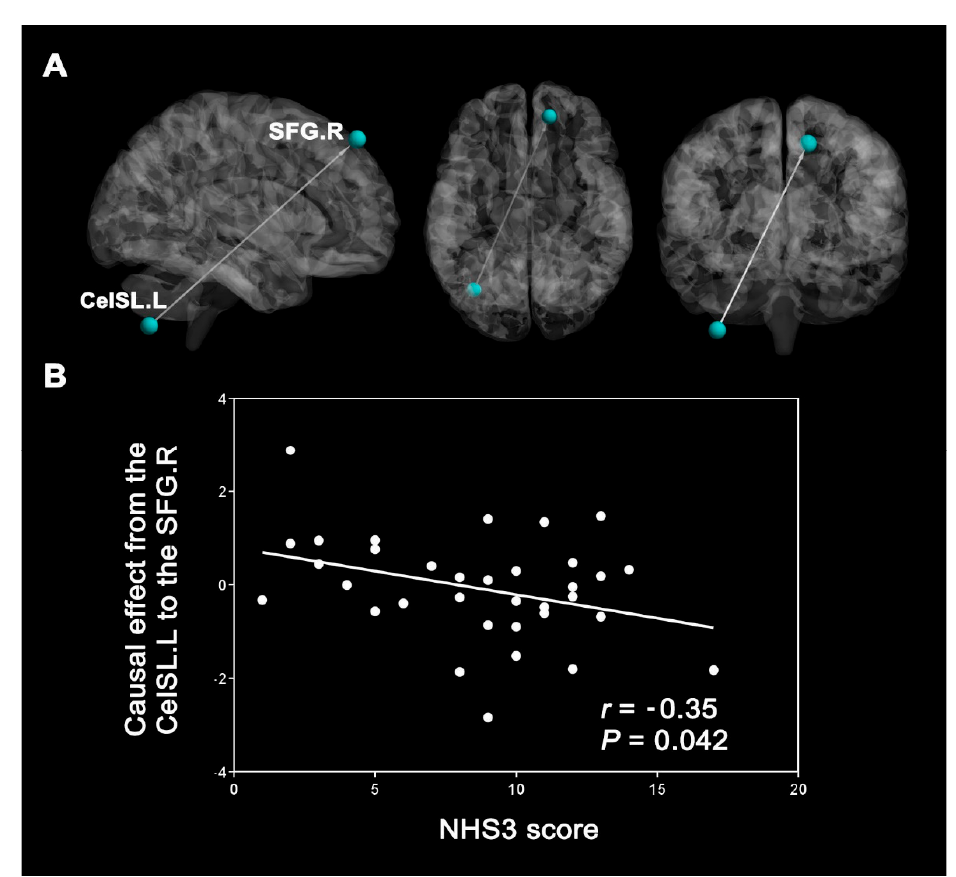
Figure 3. Correlations between the increased effective connectivity (EC) and the National Hospital Seizure Severity Scale (NHS3) scores. ( A ) The EC from the left inferior semi-lunar lobule of the cerebellum (CeISL.L) to the right superior frontal gyrus (SFG.R). ( B ) The NHS3 scores negatively correlated with the increased e ff ective connectivity from the CePL.L to the SFG.R (r = − 0.35, p = 0.042).